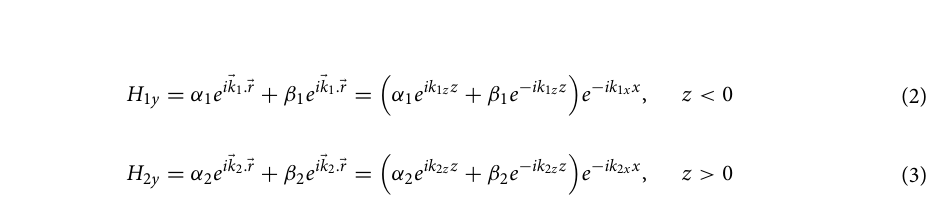
Table 1. AVT values and CIE 1931 color coordinates of FTO/ZnO/P3HT:PCBM/MoO 3 /Ag/MoO 3 (–/40/130/10/6/30 nm)